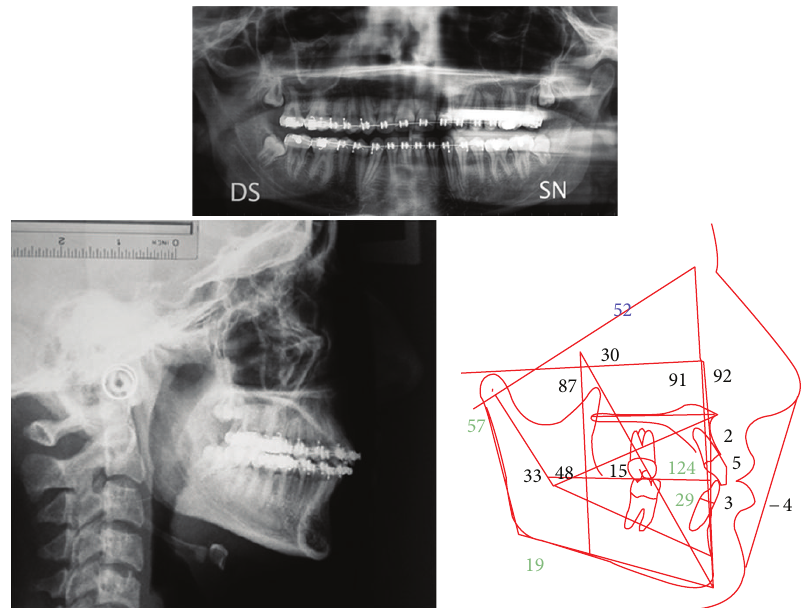
Figure 9: Panoramic and lateral radiographs with cephalometric tracing before debonding at the end of treatment.